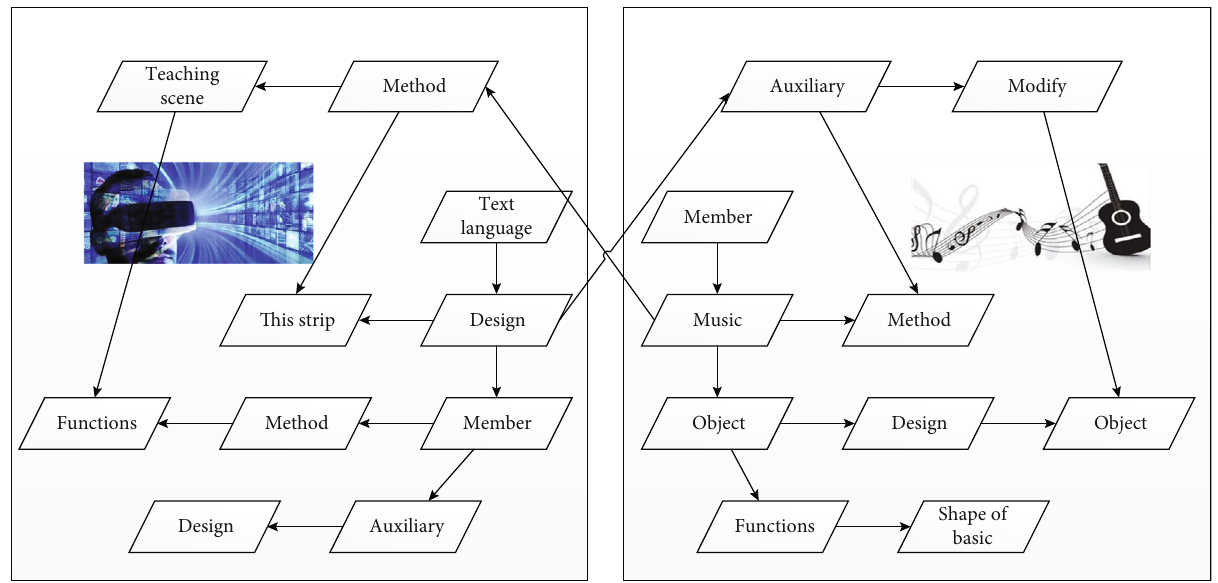
Figure 1: A brief description of music-assisted reliance on browsing